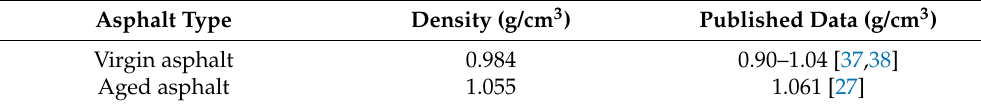
Table 2. Densities at 300